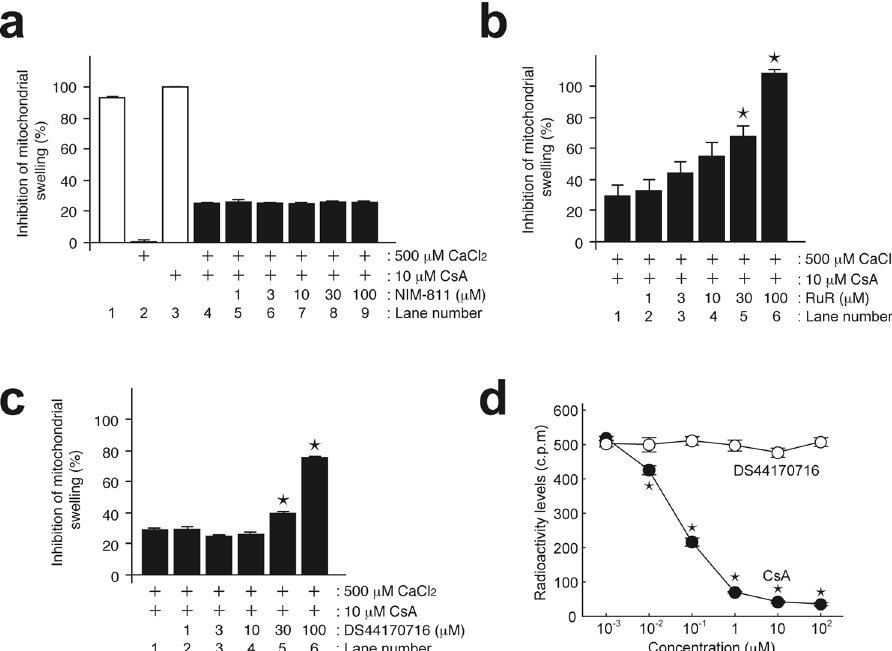
Figure 2. DS44170716 inhibits mitochondrial swelling in a different mechanism of cyclosporin A. ( a ) Effect of NIM-811 on swelling in the presence of CsA. ( b ) Effect of ruthenium red on swelling in the presence of CsA. ( c ) Effect of DS44170716 on swelling in the presence of CsA. Inhibition 0% or 100% was defined as 500 μ M CaCl 2 - treated mitochondria ( a , Lane 2) or 10 μ M CsA-treated mitochondria ( a , Lane 3), respectively. Data obtained from 3 independent samples are shown as the mean with SEM. Raw data are presented in Supplemental Fig. 2. ( d ) No significant binding activity of DS44170716 to cyclosporin A-binding site of PPIF. Binding activities of radio-labeled CsA to PPIF were measured by SPA assay. Data obtained from 3 independent samples are shown as the mean with SEM. Asterisk shows P < 0.05 compared to vehicle group (Dunnett’s